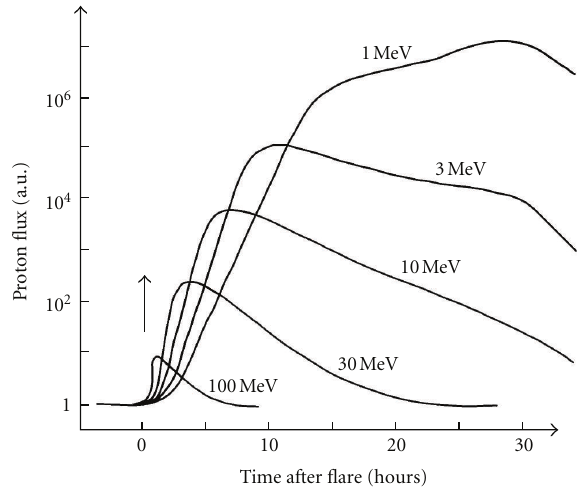
Figure14:Sketchofthediffusionalwaveofsolarprotons—temporal profiles of various energy proton fluxes at 1 AU for impulsive acceleration at the Sun at 1